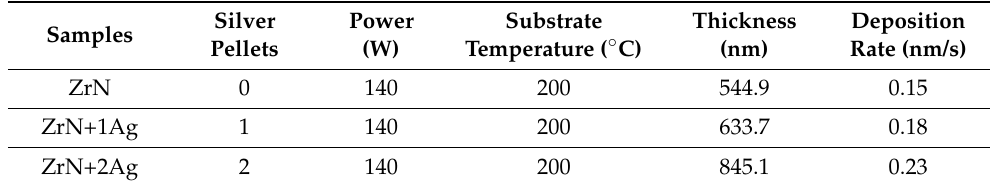
Table 2. Deposition parameter, thicknesses, and deposition rates.